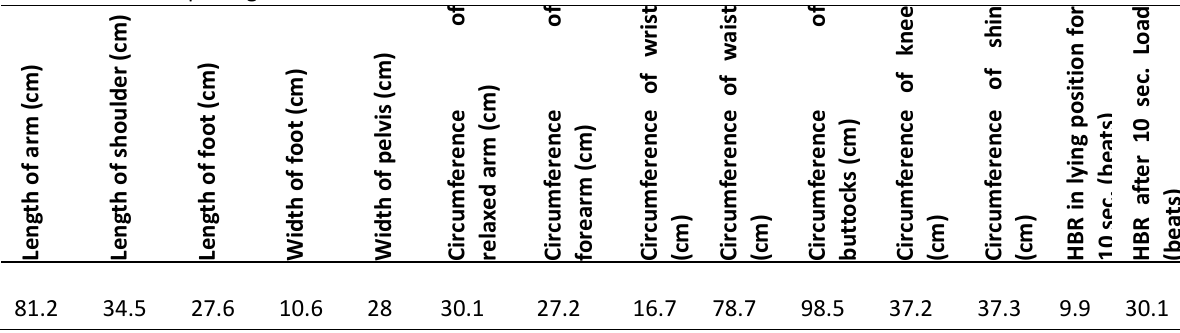
Table 2. Model morphological-functional characteristics for 50 meters’